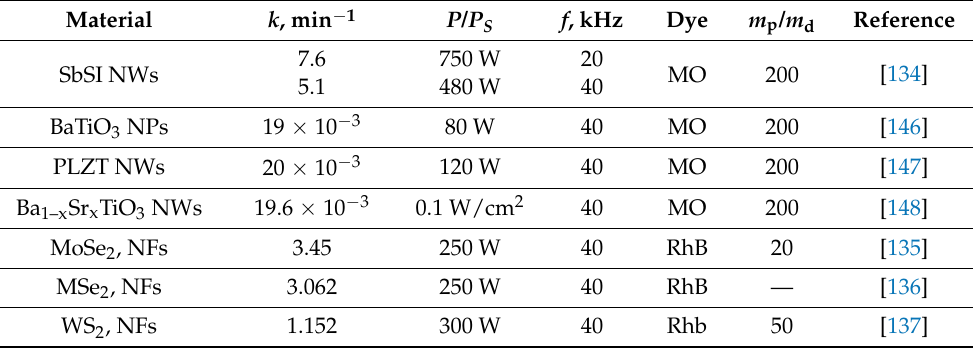
Table 4. Comparison of the reaction kinetics rate constant, k , for different nanomaterials used for the ultrasound-assisted degradation of different dye molecules (methyl orange and rhodamine B) (abbreviations: m p / m d —the ratio of piezocatalyst mass to the mass of dye molecules, P / P S —power or power density of ultrasound, f